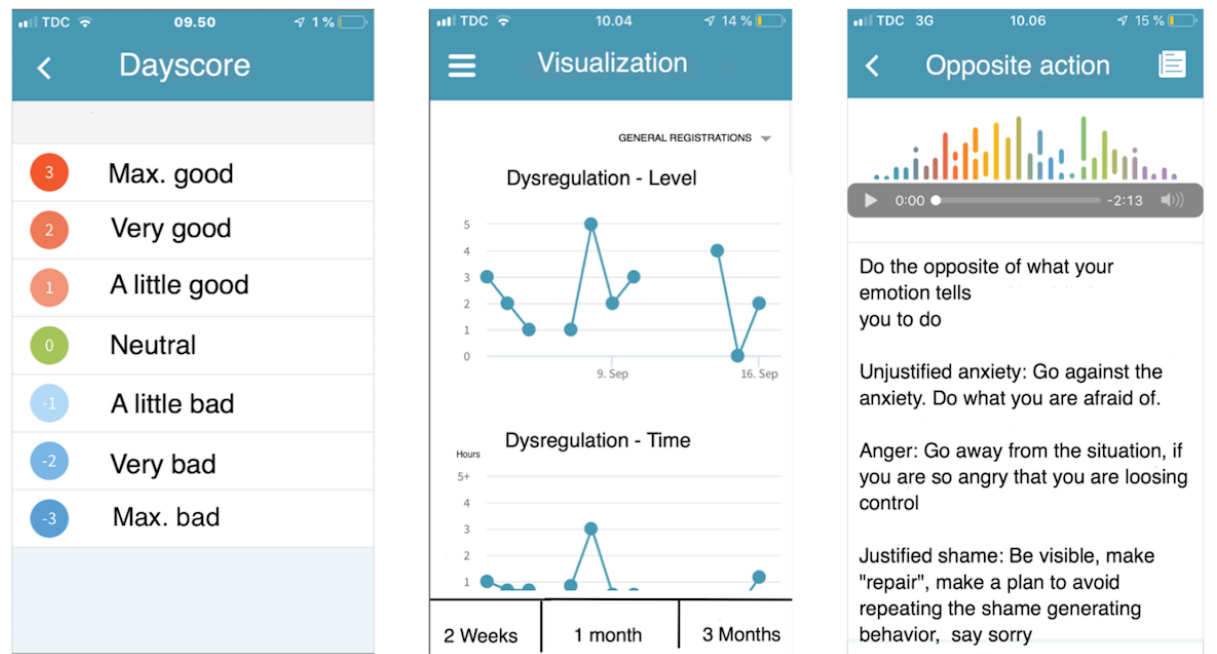
Figure 2. Screenshots of the Monsenso